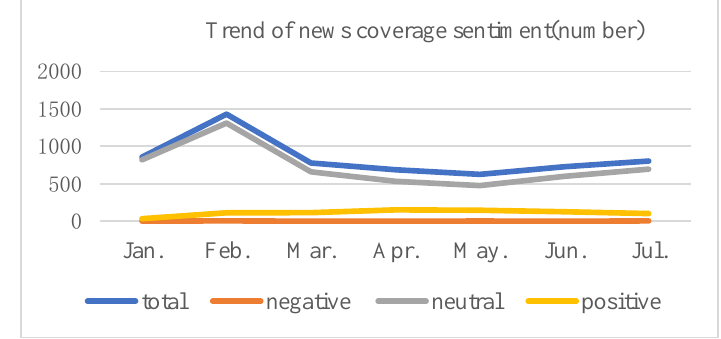
Fig. 4. Trend of news coverage sentiment